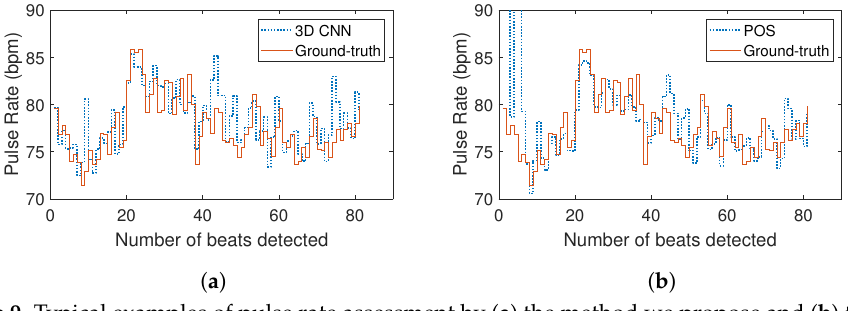
Figure 9. Typical examples of pulse rate assessment by ( a ) the method we propose and ( b ) the plane orthogonal to skin tone (POS) algorithm. Here, the two methods present relevant estimations. The pulse rate values presented in these figures were computed from the video of subject #31.